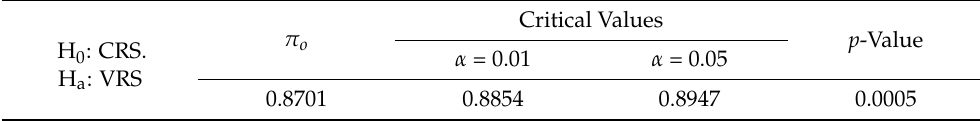
Table 3. Bootstrapped-based test of returns to scale.